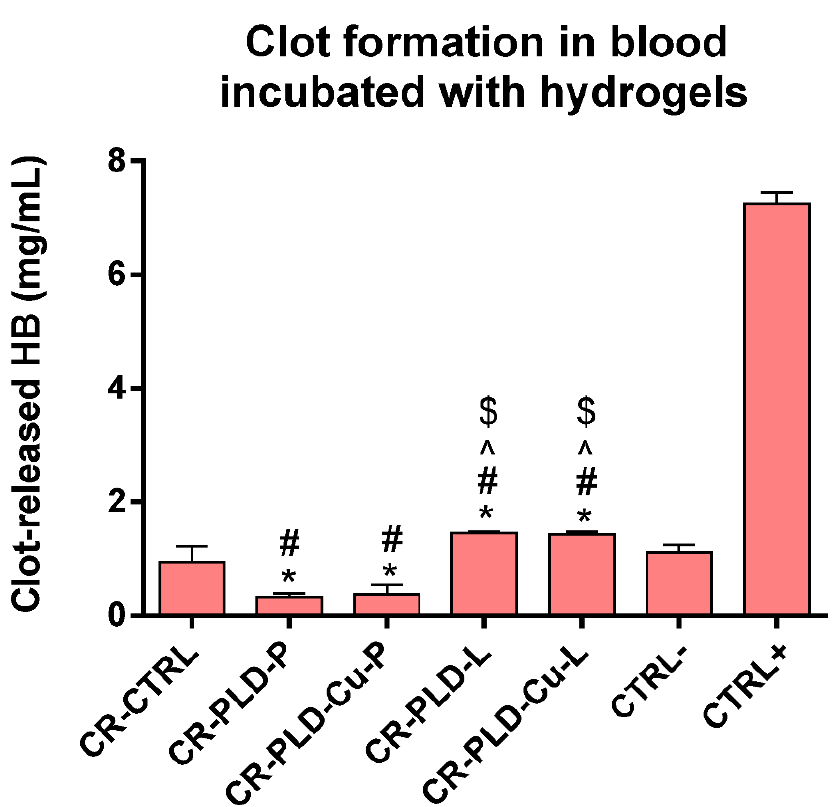
Figure 4. Clot formation in blood incubated with control and poly(L-DOPA)-modified curdlan hydrogel samples with immobilized oxidoreductases. (*) symbol indicates statistically significant differences between the negative control and other samples, (#) symbol indicates statistically significant results between CR-CTRL sample and other samples, (^) symbol indicates statistically significant results between CR-PLD-P sample and the other samples, ($) symbol indicates statistically significant results between CR-PLD-Cu-P sample and other samples. *, #, ^, $ symbols indicate statistically significant results according to One-way ANOVA with post-hoc Tukey’s test for 30 min ( p < 0.05).